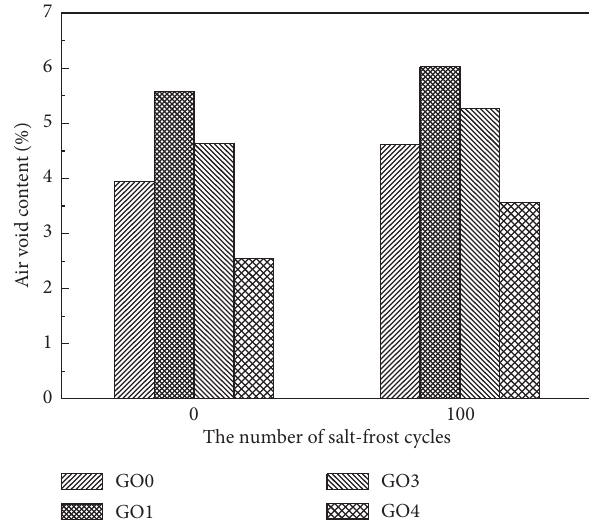
Figure 7: Air contents of GO concrete.